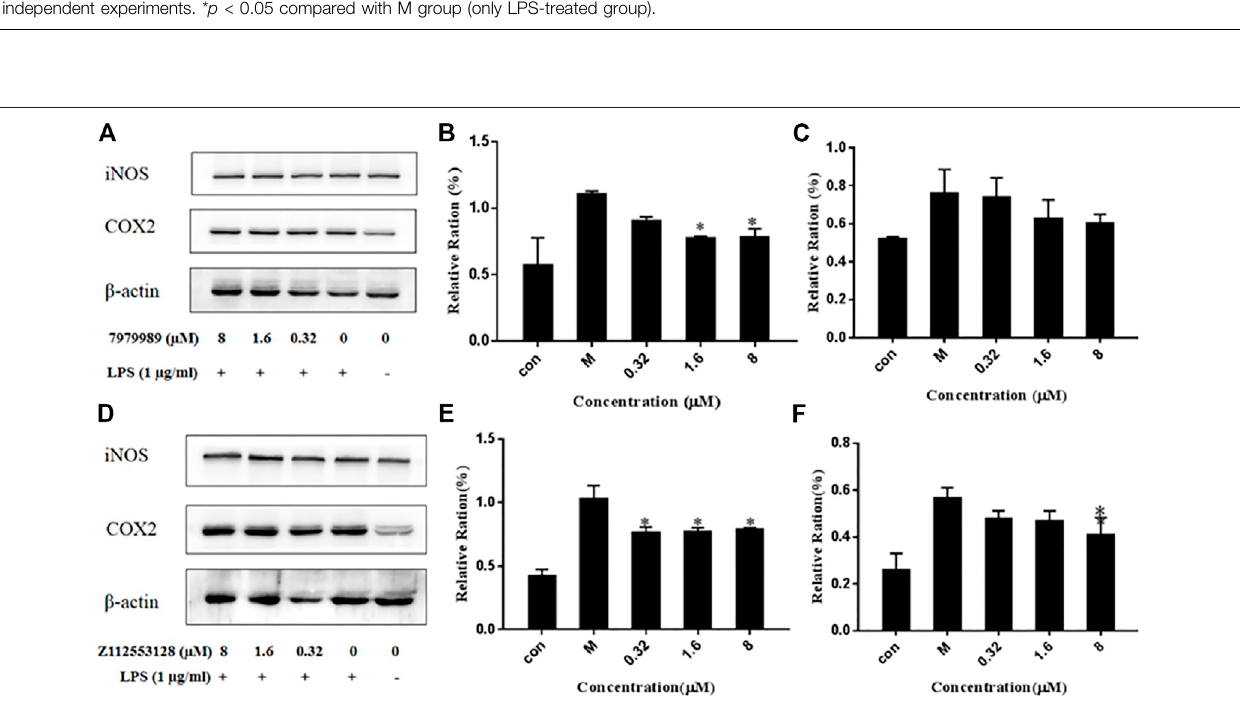
FIGURE 9 | 7979989 and Z112553128 decrease LPS-induced protein expressions of iNOS and COX-2. The protein expressions of iNOS and COX-2 were detected by western blot analysis. (A) Protein expression level after dealing with 7979989, (B) COX-2 protein expression level affected by 7979989, (C) iNOS protein expression level affected by 7979989, (D) Protein expression level after Z112553128 addition, (E) COX-2 protein expression level affected by Z112553128, (F) iNOS protein expression level affected by Z112553128. Each bar represents the mean ± standard deviation (SD) calculated from three independent experiments. * p < 0.05 compared with M group (only LPS-treated group).